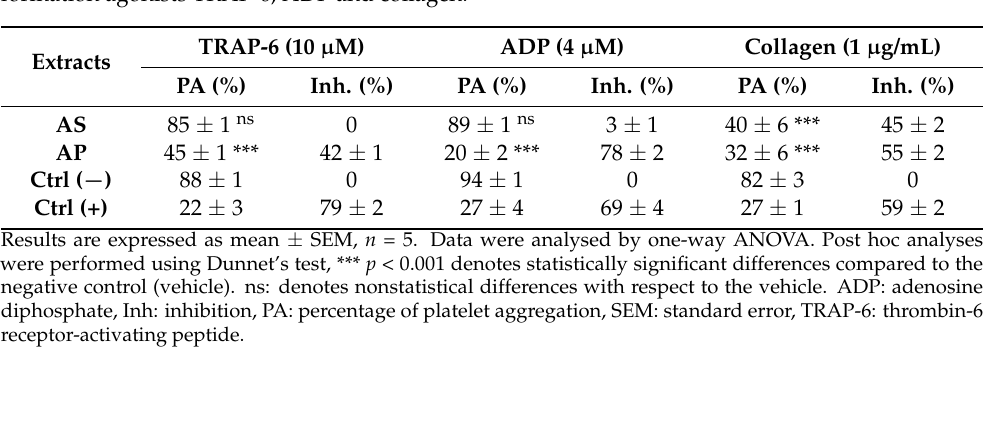
Table 5. Evaluation of platelet-aggregation inhibition of avocado seed and peel against thrombus- formation agonists TRAP-6, ADP and